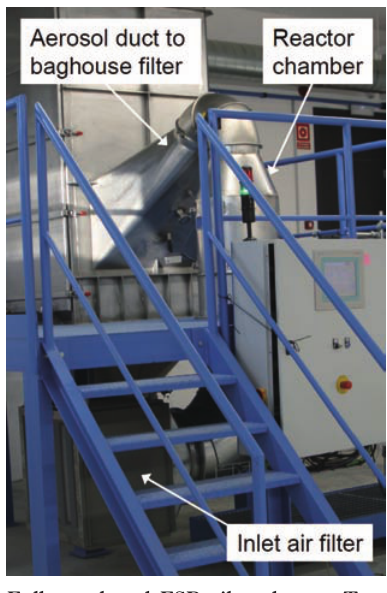
Fig. 7 Fully enclosed FSP pilot plant at Tecnan (Los Arcos, Spain): The cooling air inlet is equipped with a filter to purify the air and to prevent the release of nanoparticles in the case of an aero- sol backflow. The nanoparticle-producing spray flame is located inside the reactor chamber that is directly connected to the baghouse filter, min- imizing the aerosol